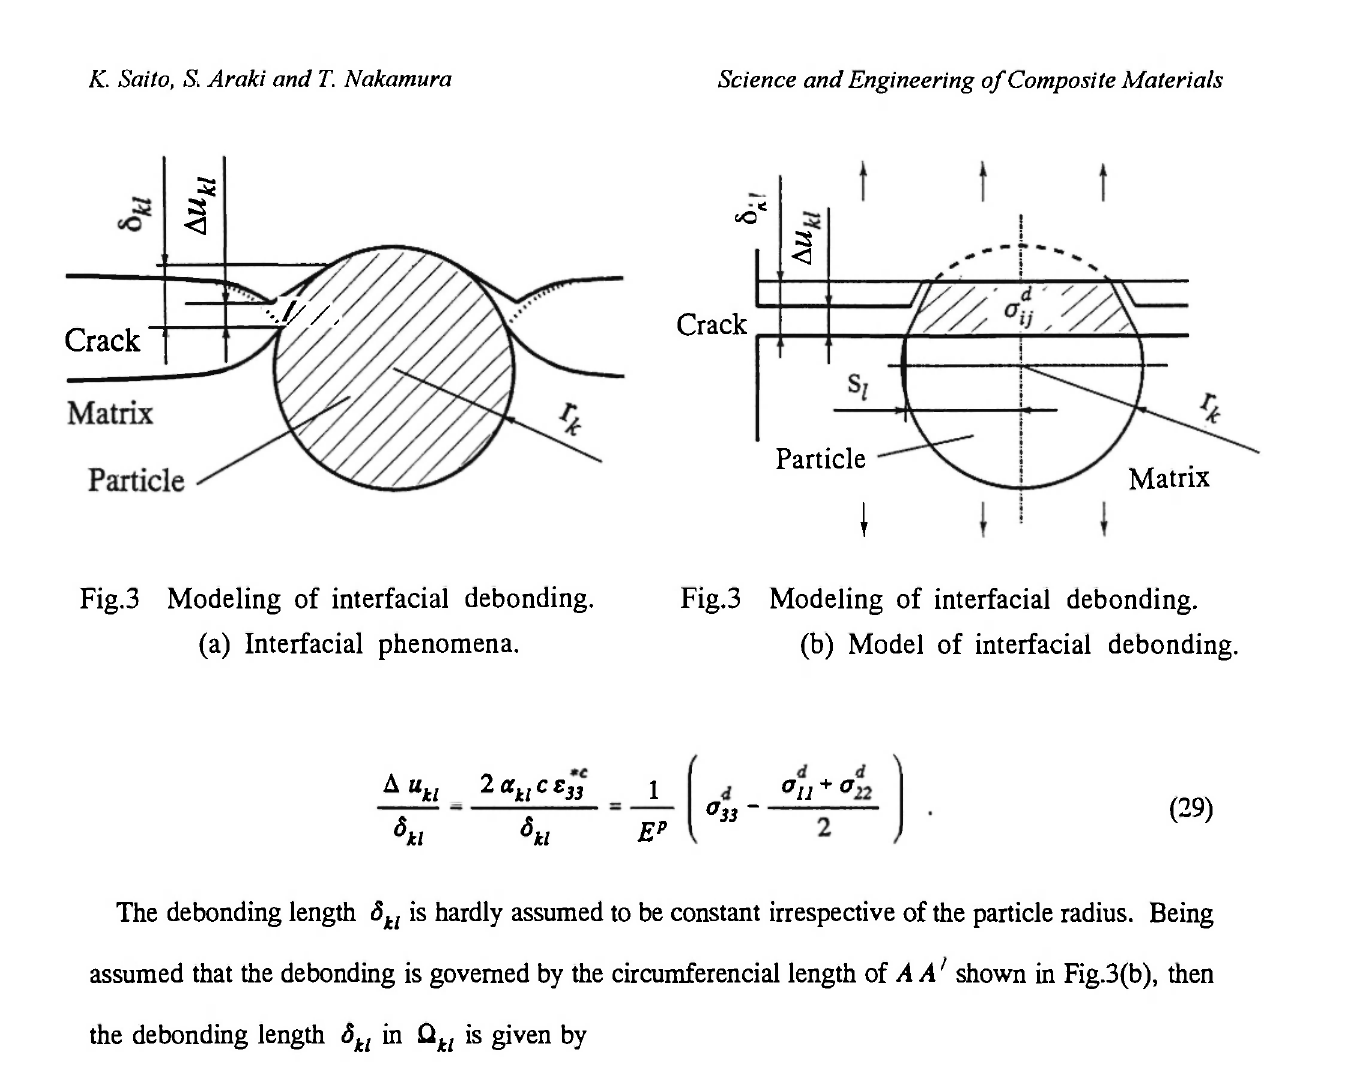
Fig.3 Modeling of interfacial debonding. (b) Model of interfacial